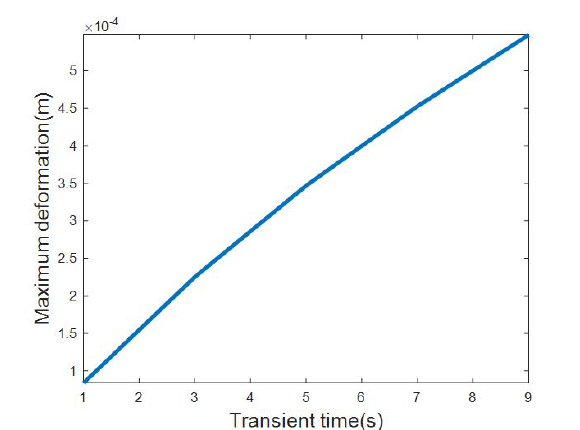
Fig. 10. Deformation distribution of plum blossom contact at 40kA/5s short-circuit current